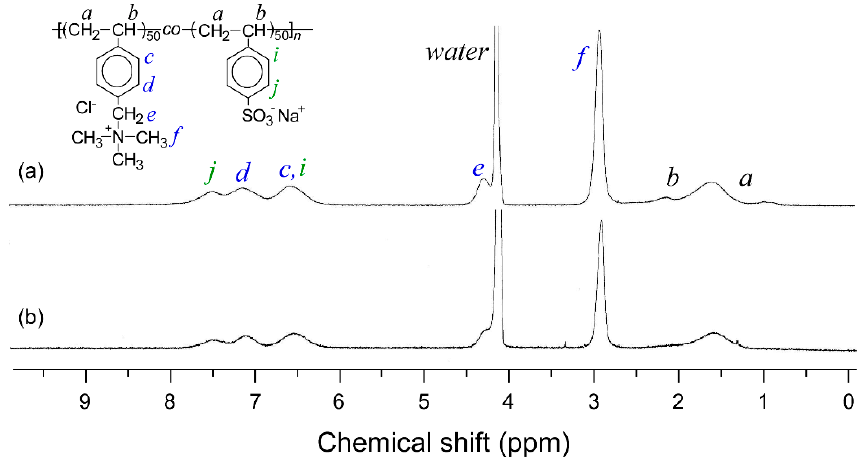
Figure 2. 1 H NMR spectra for ( a ) P(VBTAC/NaSS) 20 and ( b ) P(VBTAC/NaSS) 97 in D 2 O containing 1.2 M NaCl at 80 °C.